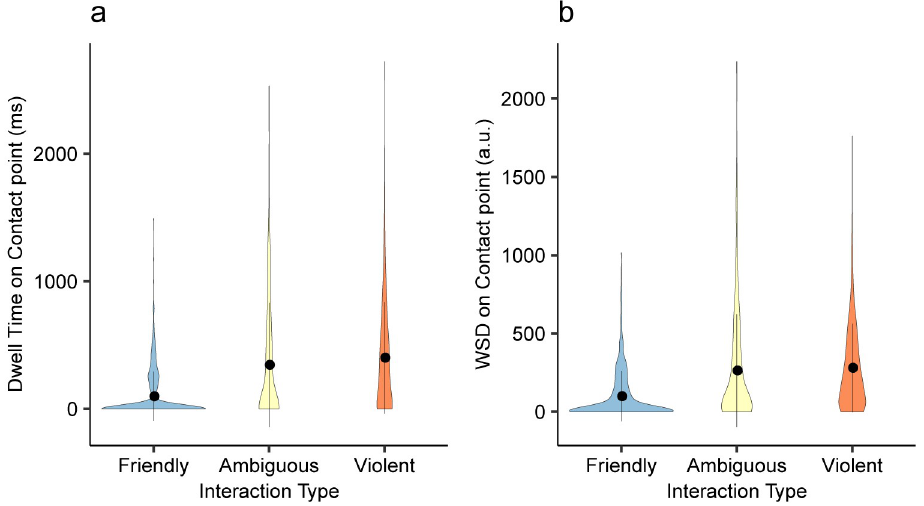
Fig 6. AOI dwell time and WSD on point of contact by interaction type. a) AOI dwell time on points of contact by predefined interaction type. b) WSD on points of contact by predefined interaction type. Error bars represent ± 1 SD. Although the values look similar, WSD and AOI dwell time uses different metrics and cannot be compared